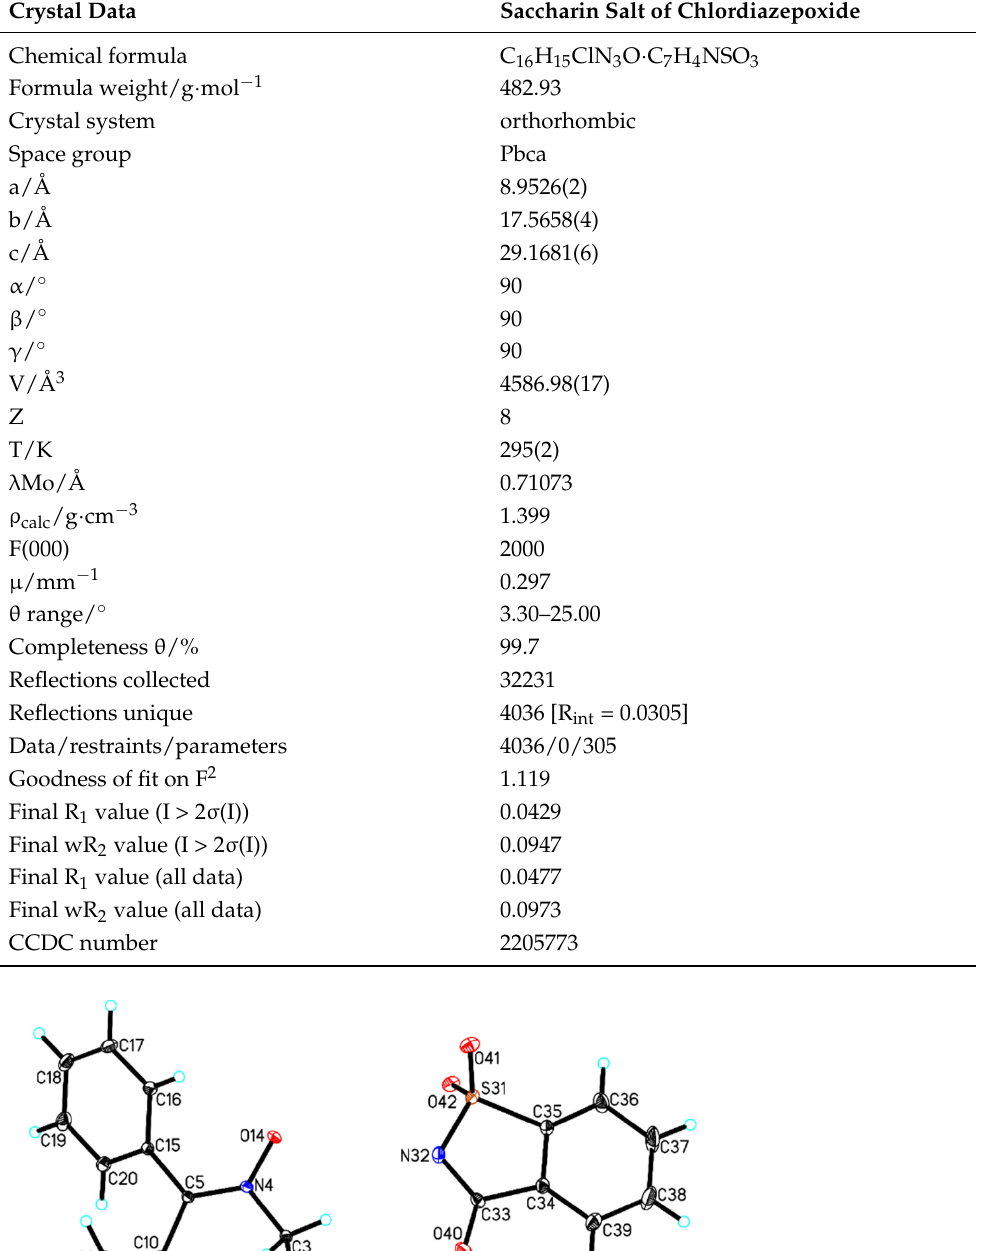
Table 2. Crystal data and structure refinement for saccharin salt of chlordiazepoxide.